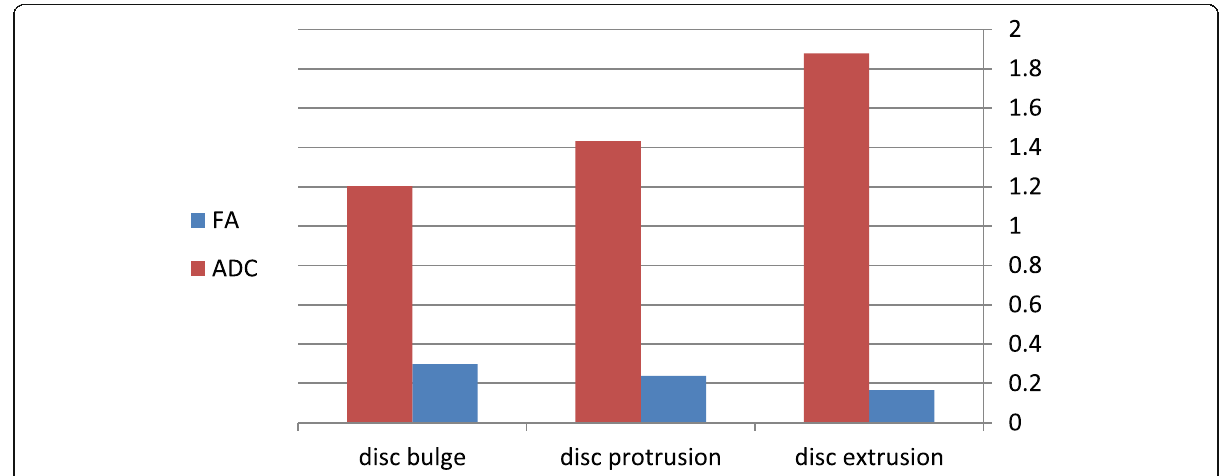
Fig. 1 Comparison between DTI parameters in patients with disc bulge, protrusion, and